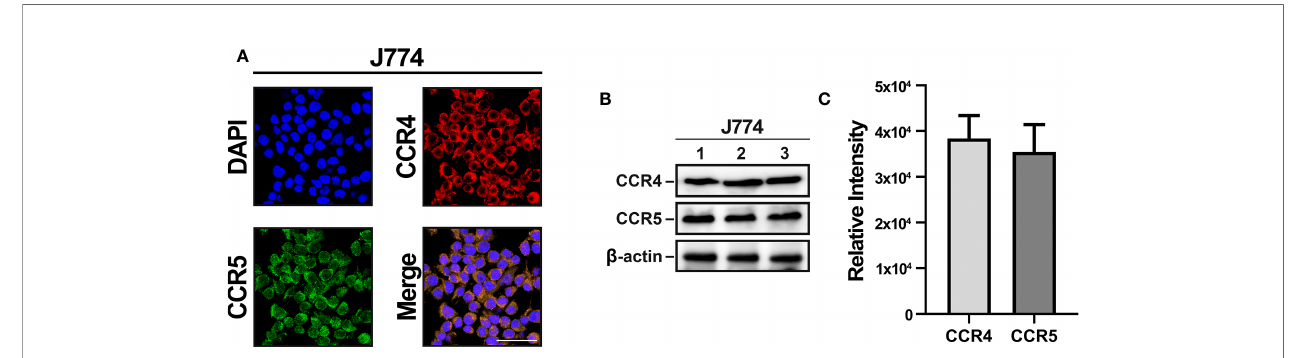
FIGURE 2 | CCR4 and CCR5 expression in J774 cells. (A) Confocal images show similar levels of CCR4 and CCR5 expression in the J774 membrane. (B) Immunoblotting detected by HRP oxidation also indicates CCR4 and CCR5 expression. (C) Quantitative results of CCR4 and CCR5 through Image J. (n=3/group, scale bar=25 µm).